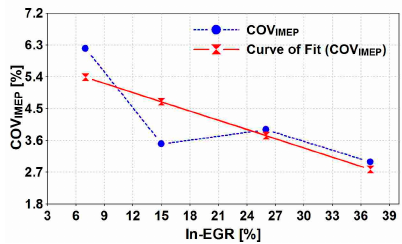
Figure 12. Cyclic variability of IMEP due to variation of In-EGR setting (rpm = 3000, IMEP = 2.1 bar, T epc = 525 – 530 K).